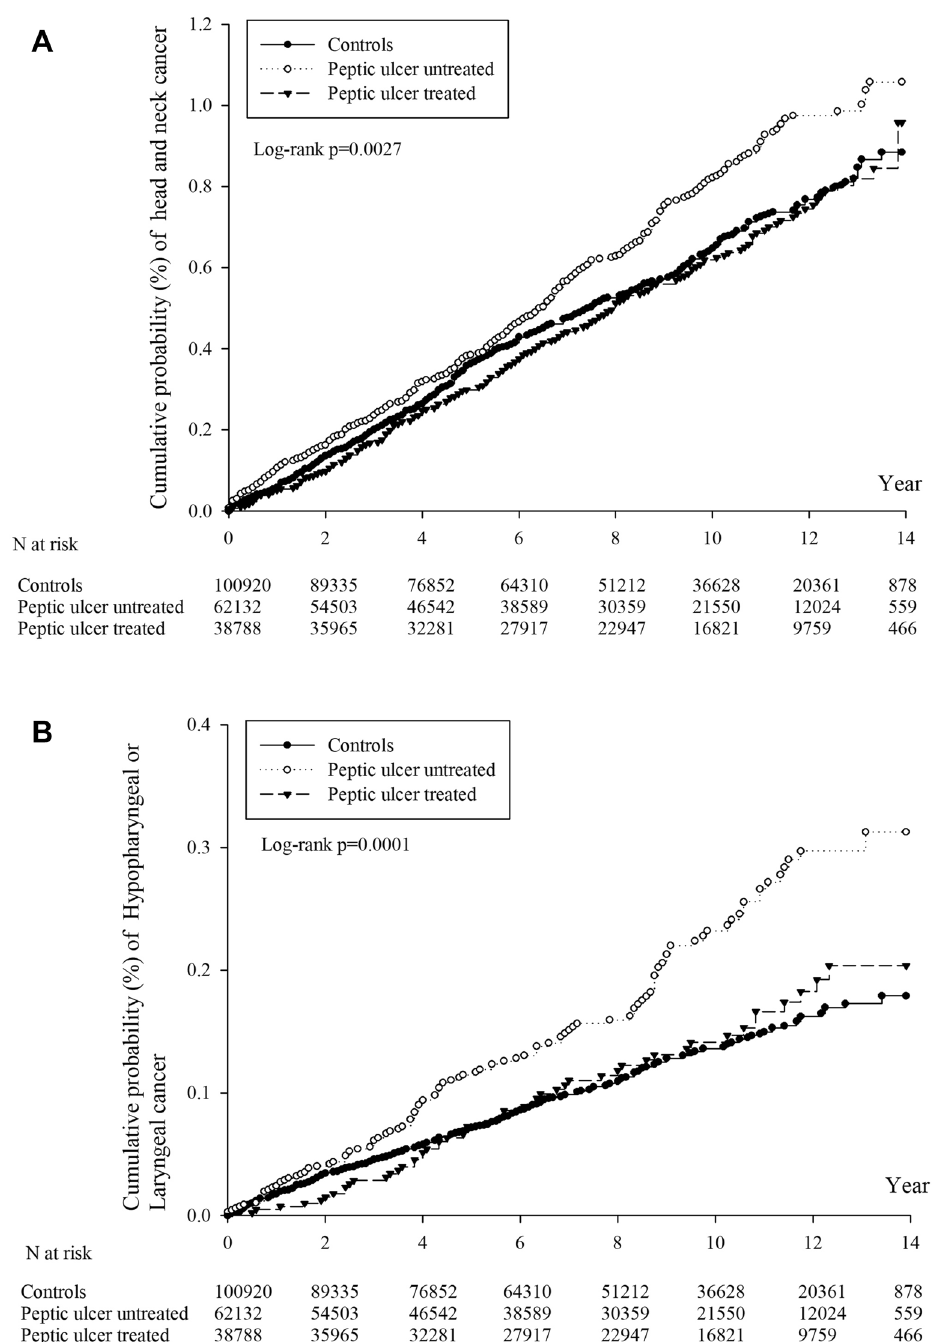
Figure 2. ( A ) The cumulative incidence functions of HNC for peptic ulcer without eradication, peptic ulcer with eradication and controls. ( B ) The cumulative incidence functions of hypopharyngeal/laryngeal cancer for peptic ulcer without eradication, peptic ulcer with eradication and